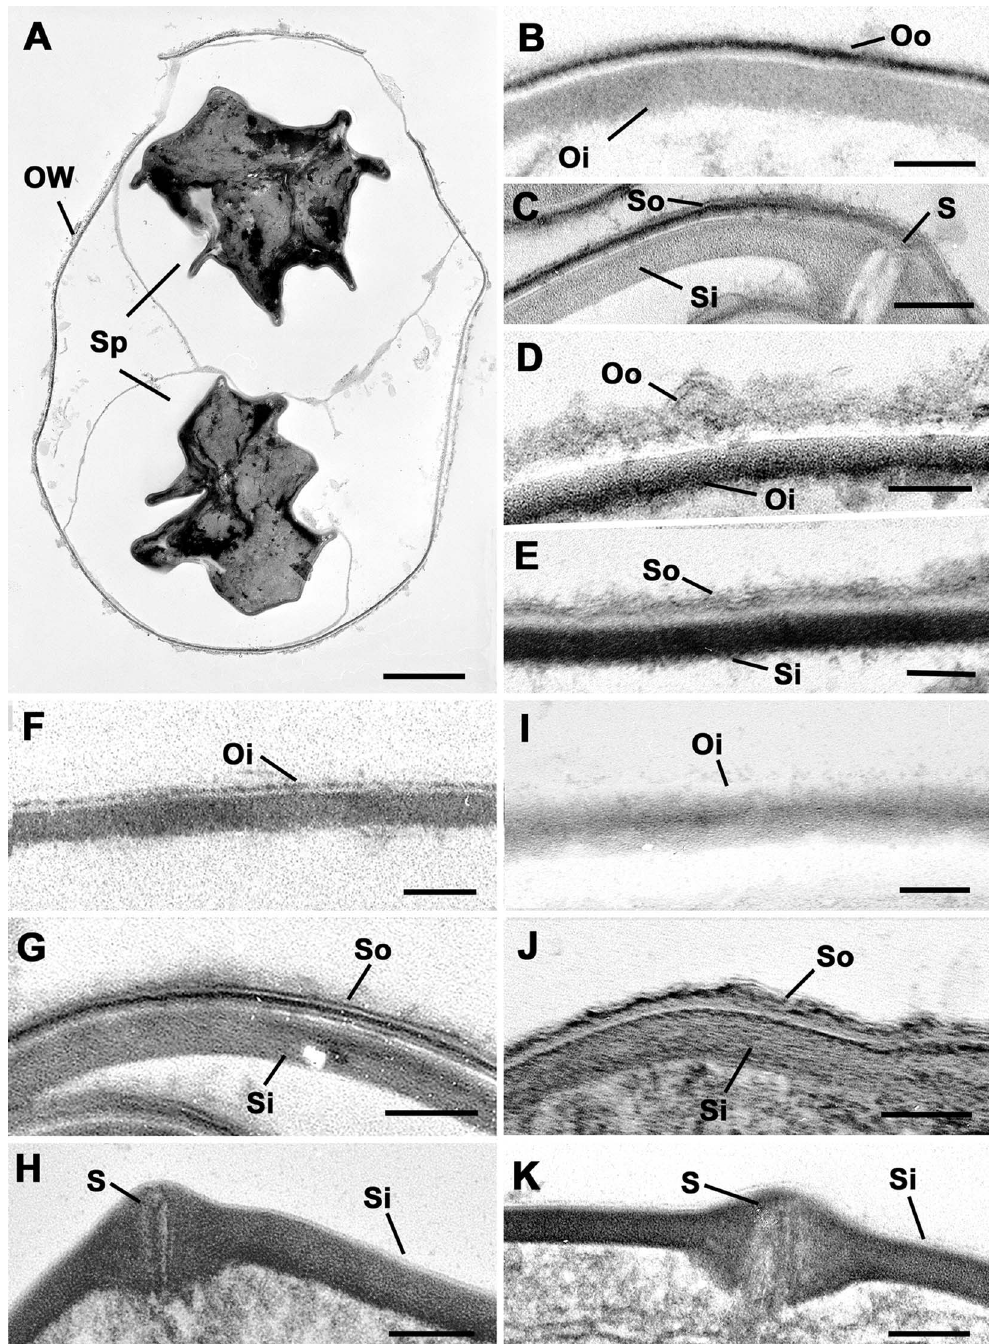
Figure 1. Electron micrographs of the walls of oocysts and sporocysts undergoing various treatments. A bar represents 1 l m in A and 100 nm in the other micrographs. (A) Section through an intact oocyst showing the two collapsed sporocysts (Sp). OW – oocyst wall. (B) Detail of an untreated oocyst showing the outer (Oo) and inner (Oi) layers of the oocyst wall. (C) Detail of an untreated oocyst showing the outer (So) layer and the plates of the inner (Si) layer of the sporocyst wall connected by a thicken suture (S). (D) Enlargement of a heat-treated oocyst showing the retention of both the outer (Oo) and inner (Oi) layers oocyst wall. (E) Enlargement of a heat-treated oocyst showing the retention of both the outer (So) and inner (Si) layers of the sporocyst wall. (F) Detail of the wall of an oocyst after treatment with bleach showing the inner (Oi) layer, but loss of the outer layer of the oocyst wall. (G) Bleach-treated intact oocyst showing the retention of both the outer (So) and inner (Si) layer of the sporocyst wall. (H) Naked sporocyst treated with bleach showing the loss of the outer layer, but retention of the inner (Si) layer of the sporocyst wall. S – suture. (I) Detail of an oocyst treated with bleach and heating showing the inner (Oi) layer, but loss of the outer layer of the oocyst wall. (J) Bleach and heat treated intact oocyst showing the retention of both the outer (So) and inner (Si) layer of the sporocyst wall. (K) Naked sporocyst treated with bleach and heating showing the loss of the outer layer, but retention of the inner (Si) layer of the sporocyst wall. S –